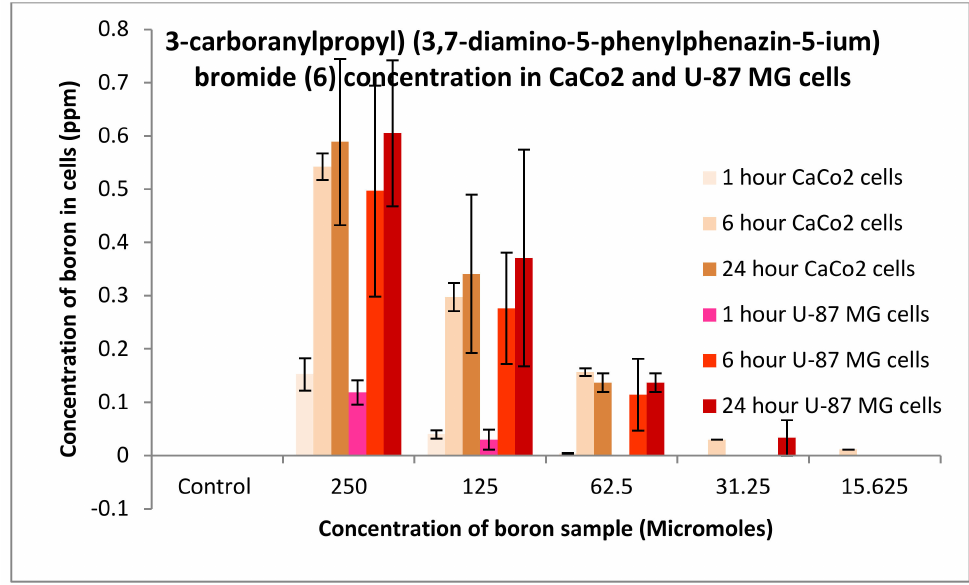
Figure 18. Uptake of boron for 3-carboranylpropyl) (3,7-diamino-5-phenylphenazin-5-ium) bromide (6) into CaCo2 and U87 MG cells after 1, 6 and 24 h.